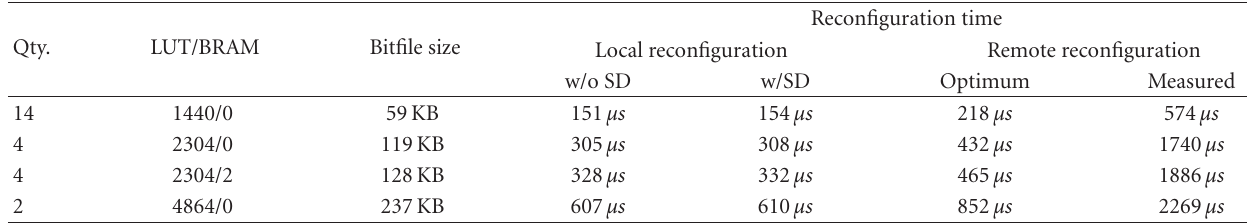
Table 5: Slot size distribution and reconfiguration time.